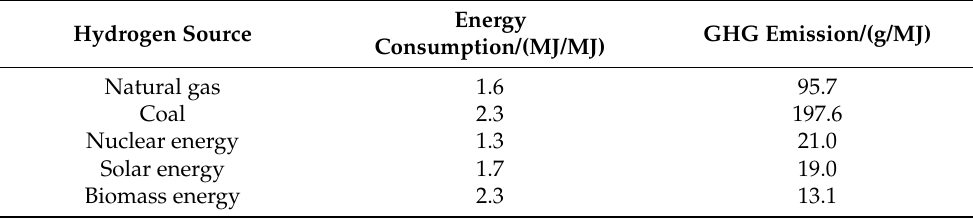
Table 3. Hydrogen life-cycle energy consumption and GHG